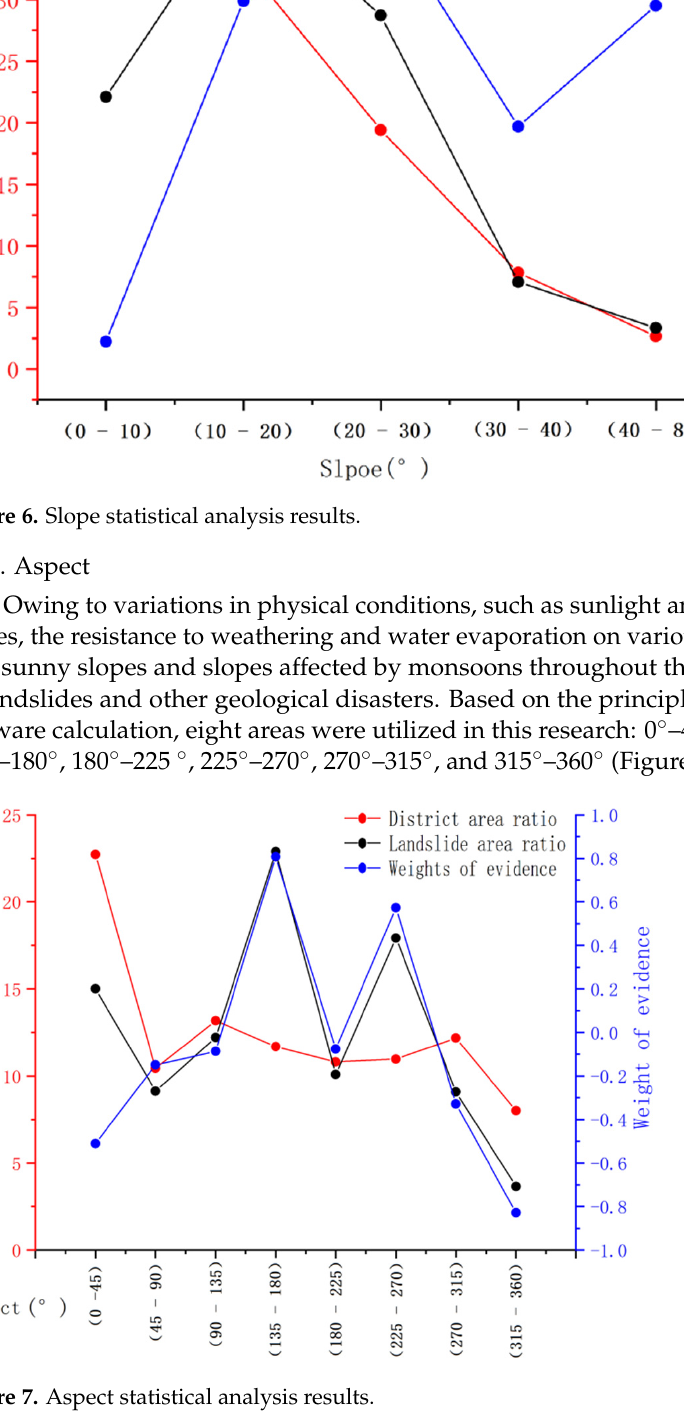
Figure 5. Elevation statistical analysis results. 4.1.2. Slope The slope affects surface water collection, groundwater infiltration, groundwater